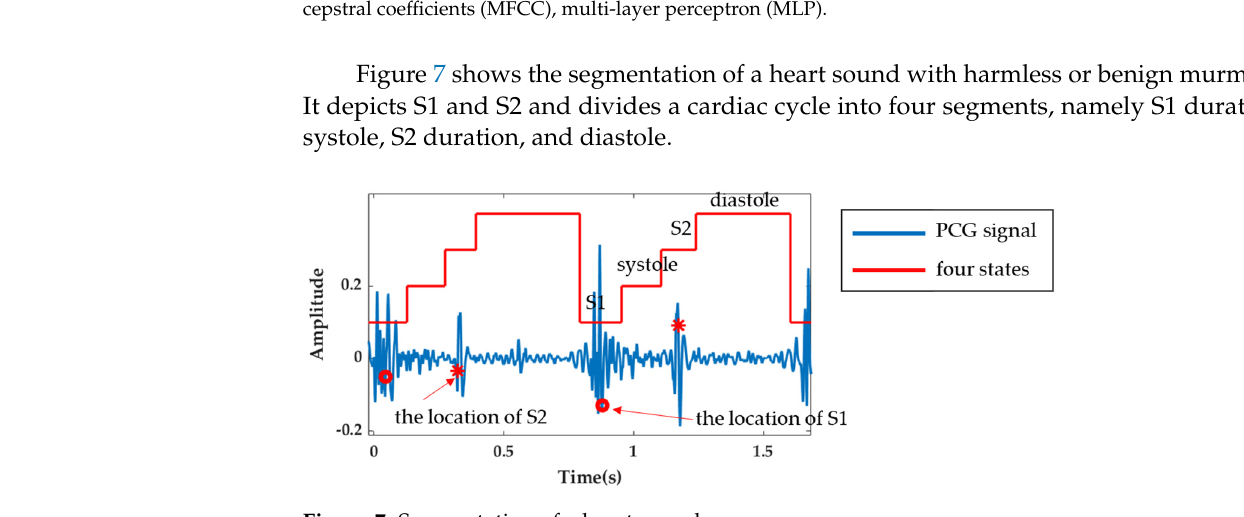
Figure 7. Segmentation of a heart sound.